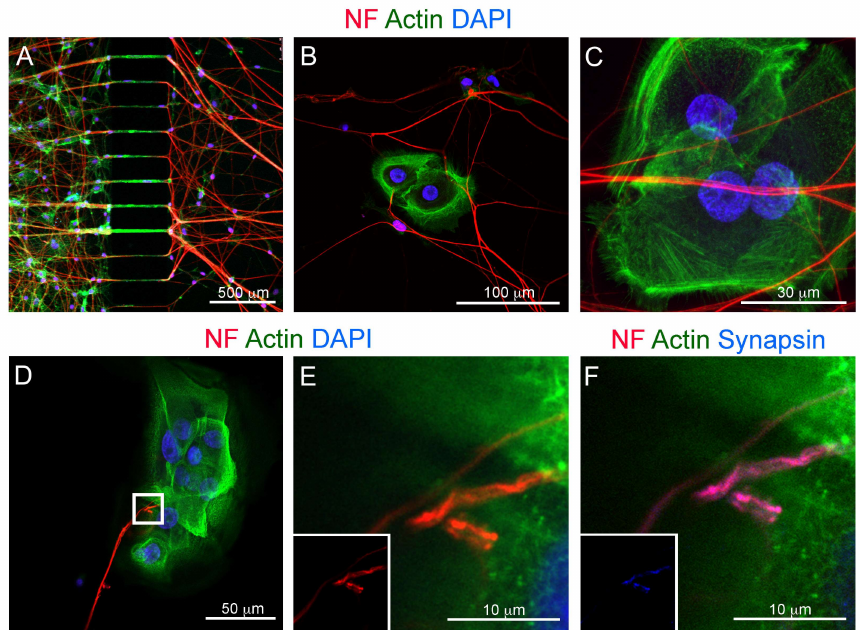
Figure 7. Confocal microscopy imaging of co-cultures of trigeminal ganglia and AB10 ameloblastoma cells. ( A ) Double immunofluorescent staining against neurofilament (red color) and actin (phalloidin; green color) showing passage of axons from the neuronal culture chamber to the AB10-containing culture chamber. Blue color: DAPI. ( B ) Double immunofluorescent staining against neurofilament (red color) and actin (phalloidin; green color) showing axonal networks formed by trigeminal neurons in correspondence of AB10 cells. Blue color: DAPI. ( C ) 3D projection of the innervation of a cluster of AB10 cells. Neurofilament (red color) marks axons and phalloidin (against actin; green color) marks AB10 cells cytoskeleton. Blue color: DAPI. ( D ) Double immunofluorescent staining against neurofilament (red color) and actin (phalloidin; green color) showing axonal branching and establishment of multiple connections upon contact of trigeminal axons with AB10 cells. Blue color: DAPI. ( E ) Higher magnification of D (white box in D indicates the region showed in E). Insert shows single channel immunofluorescent staining against neurofilament. ( F ) Triple immunofluorescent staining against neurofilament (red color), actin (green color) and Synapsin I (blue color) showing accumulation of synapsin at the sites of axon / AB10 cells contact. Insert shows single channel immunofluorescent staining against Synapsin I. Scale bars: ( A ): 500 µ m; ( B ): 100 µ m; ( C ): 30 µ m; ( D ): 50 µ m; ( E ): 10 µ